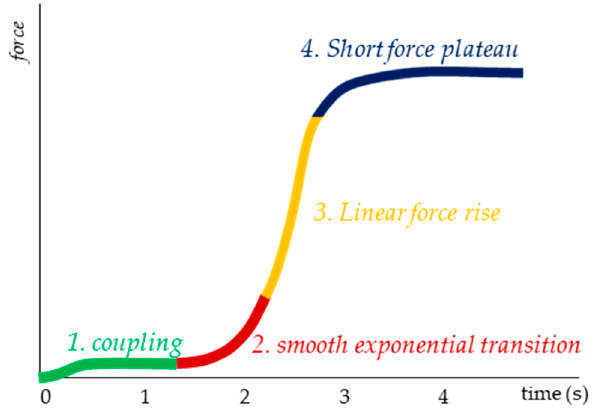
Figure 2. Schematical force profile including the phases of force